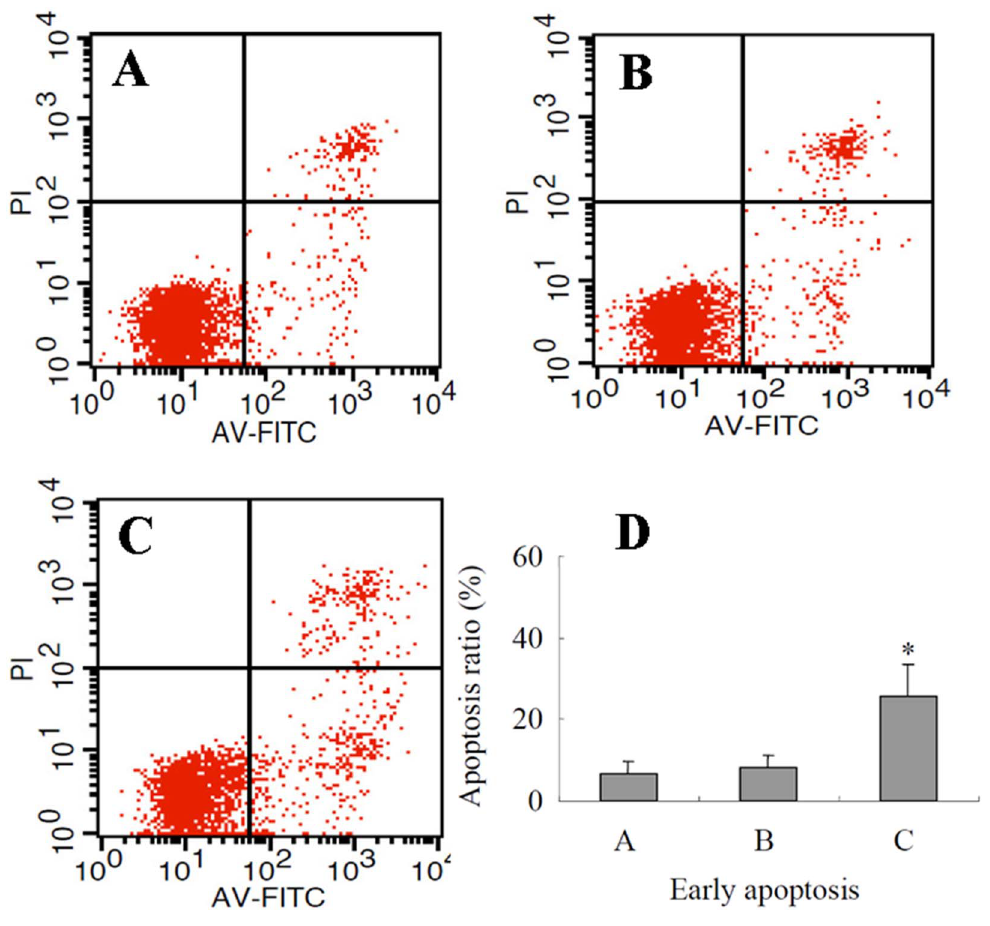
Figure 5. The effect of anti-FST antibody on apoptosis of activin A-induced lung adenocarcinoma cell line A549 cells. A549 cells were incubated for 24 hours in the absence of activin A (A), presence of 10 ng/ml activin A (B) or 1 m g/ml anti-FST monoclonal antibody + 10 ng/ml activin A (C). A549 cells were stained by Annexin V-Alexa Fluor-488/PI and the stained cells were analyzed by flow cytometry to determine the percentages of AnnexinV + /PI 2 (early apoptosis) and AnnexinV + /PI + (late apoptosis) cells. The graph represents means and S.D of triplicate determinations. * P , 0.01, compared with 10 ng/ml activin A group and 0 control.